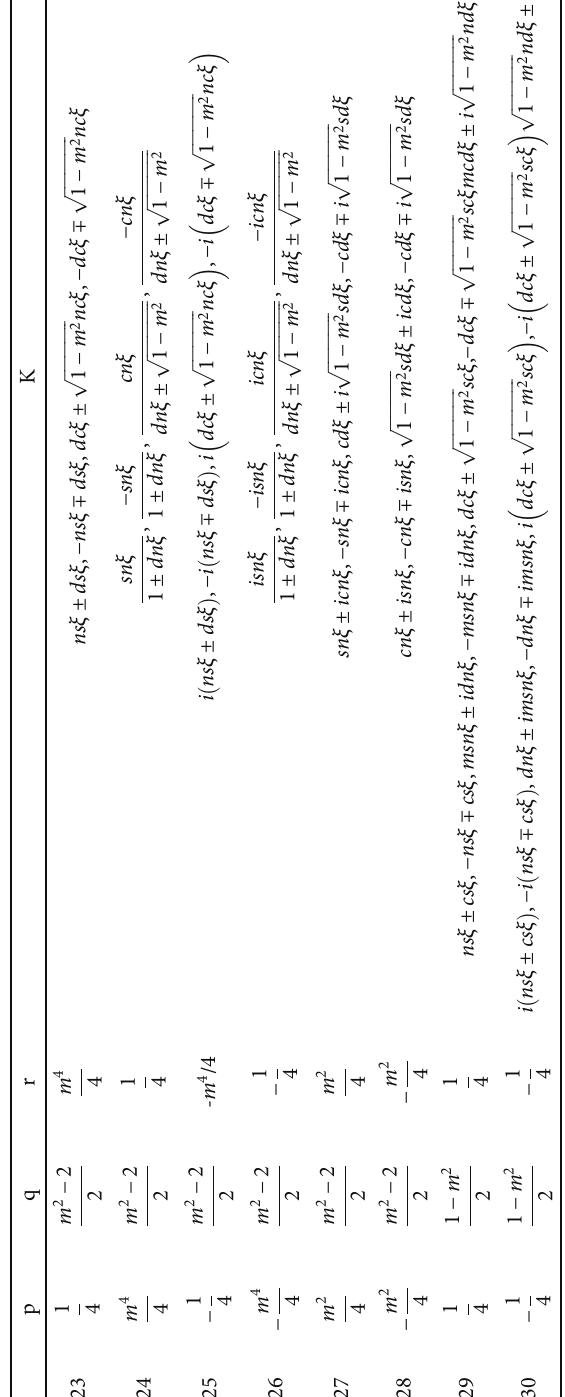
ffiffiffiffiffiffiffiffiffiffiffiffiffi m − 1